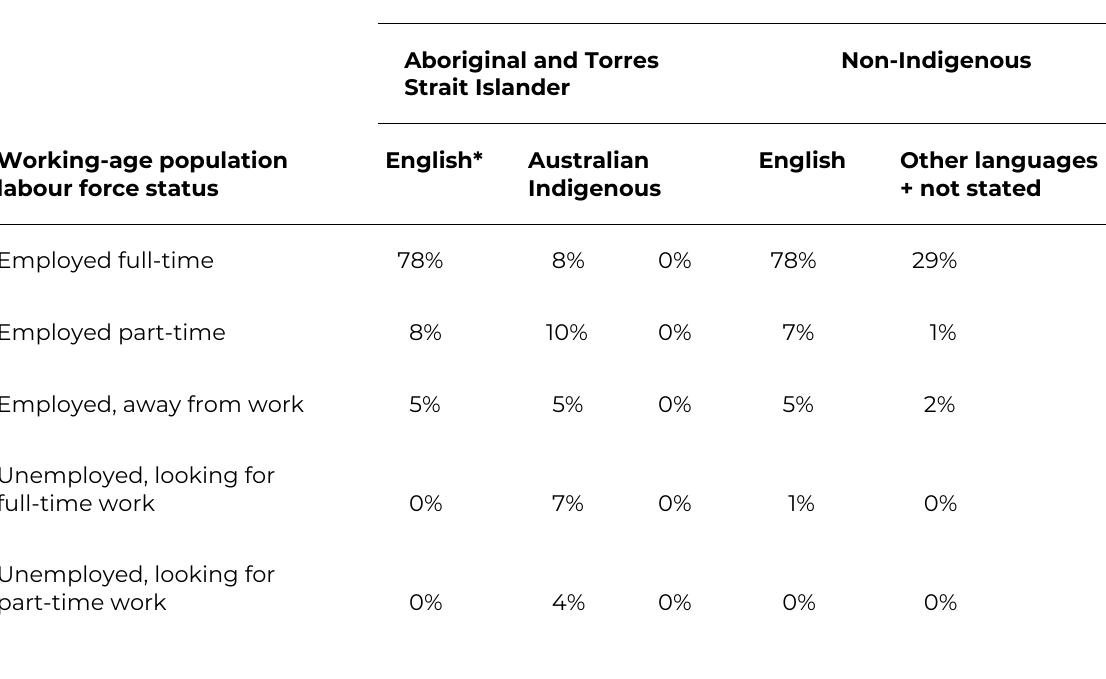
Table 1. Labour force status, Aboriginal and Torres Strait Islander status and language spoken at home, 2016, for Petermann-Simpson region 3 (ABS,